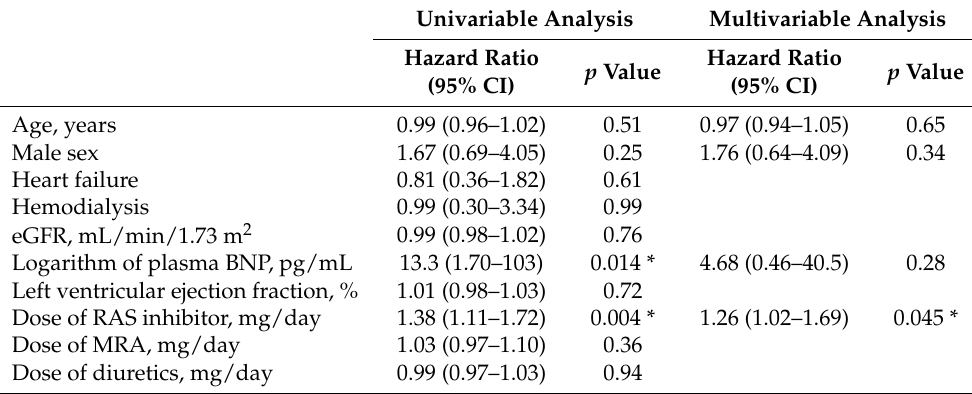
Table 2. Potential factors associated with recurrence of hyperkalemia within 3 months following SZC cessation. Univariable Analysis Multivariable